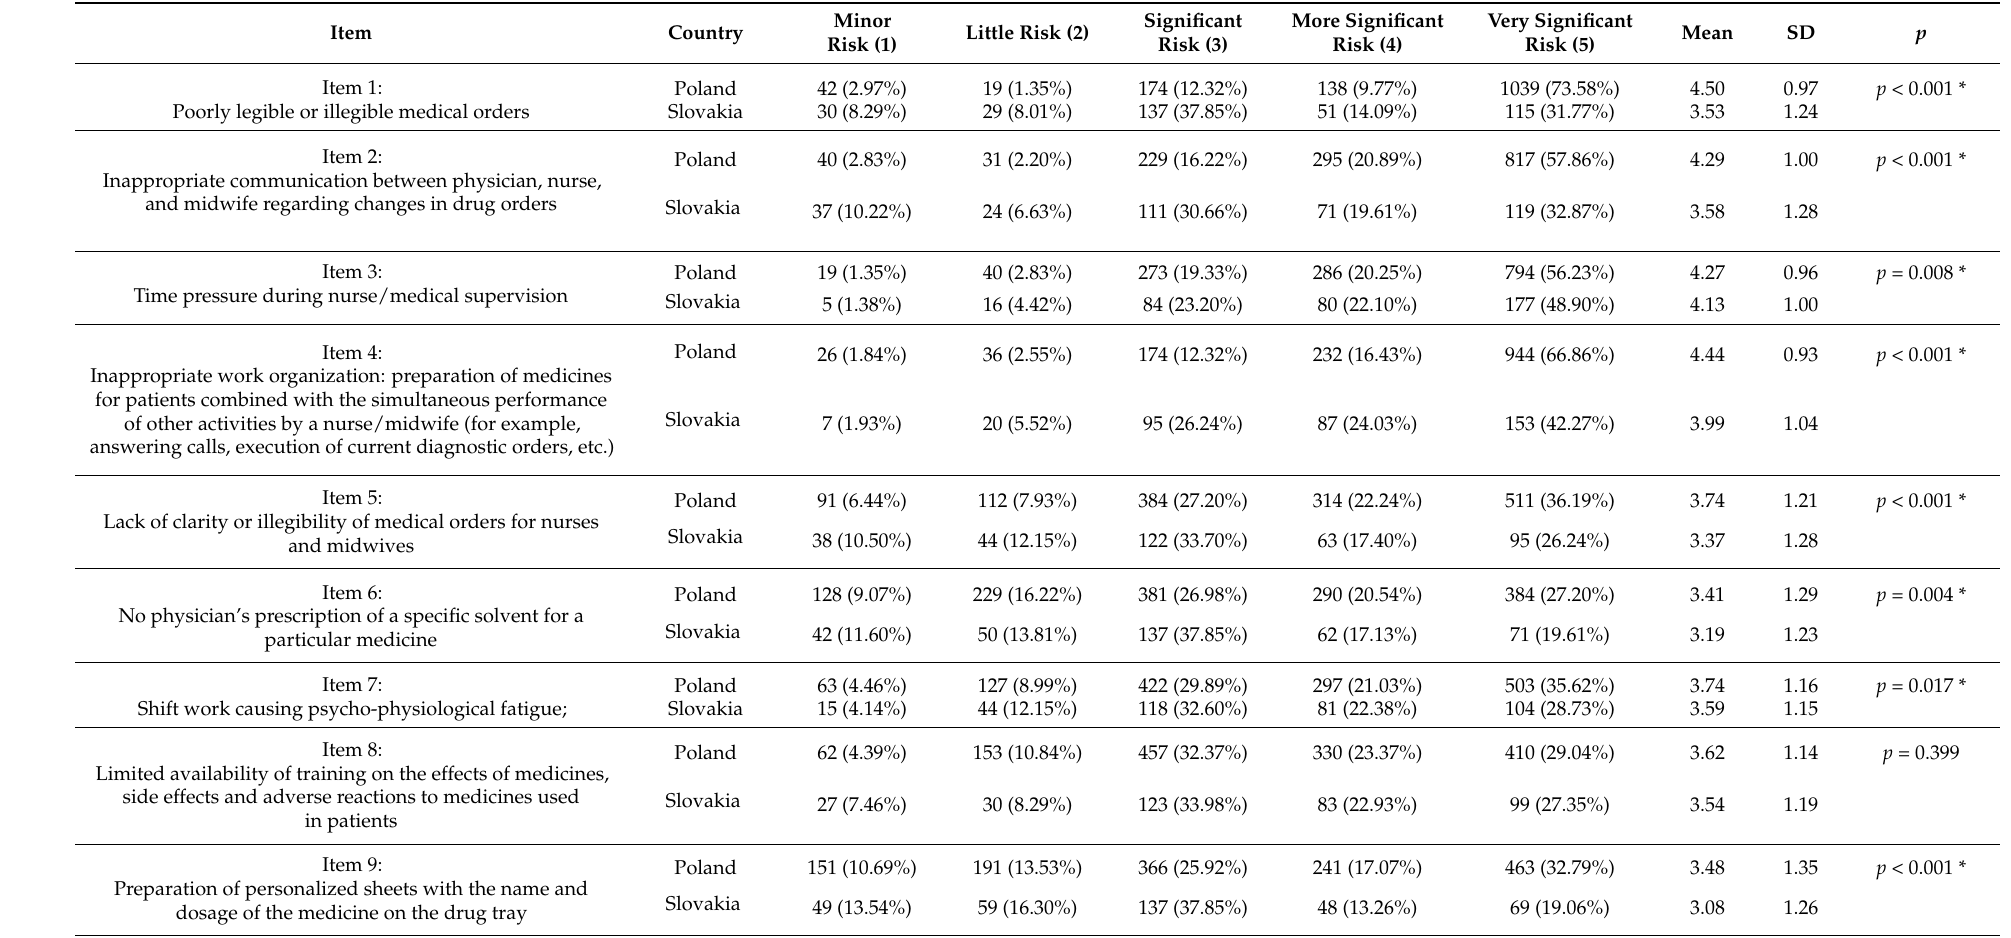
Table 3. Results for individual risk factors in pharmacotherapy in Polish and Slovak